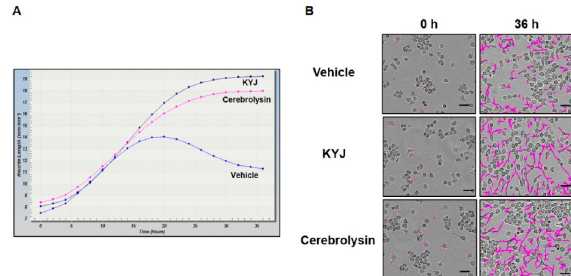
Figure 2. KYJ extended the neurite length of N2a cells. ( A ) The measurement of neurite length was conducted at various time points until 36 h. ( B ) Neurite length was measured and representative images were taken at 0 h and after 36 h. Scale bar = 50 µm.